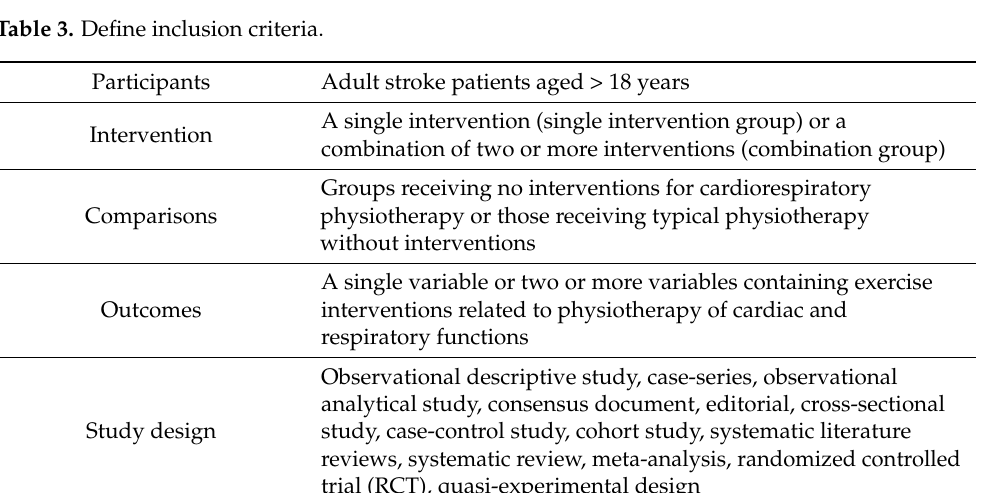
Table 3. Define inclusion